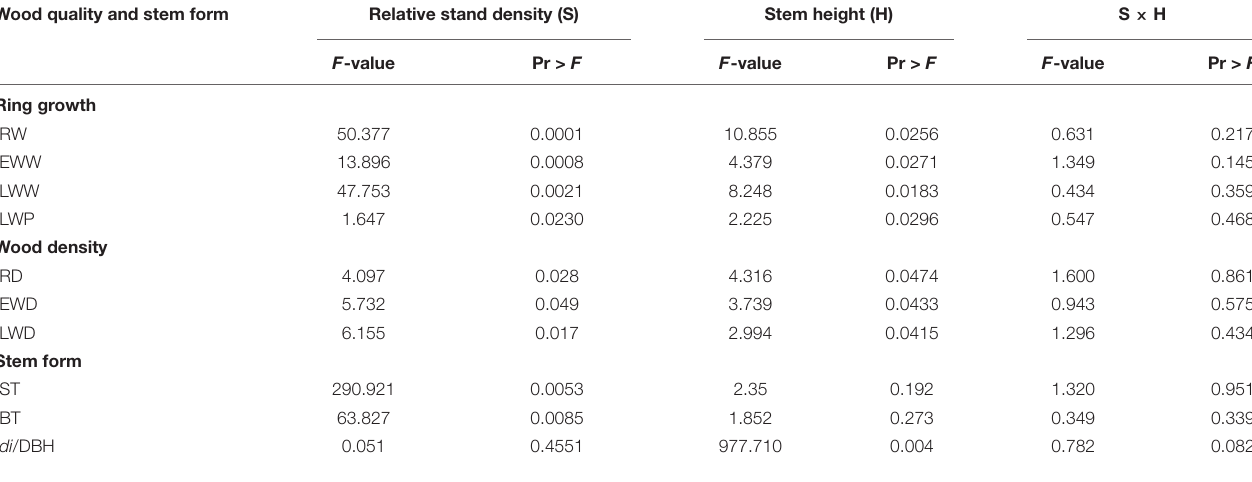
TABLE 2 | Influence of the main and interactive effects of relative stand density and stem height on three dimensions, architecture, and wood properties. Wood quality and stem form Relative stand density